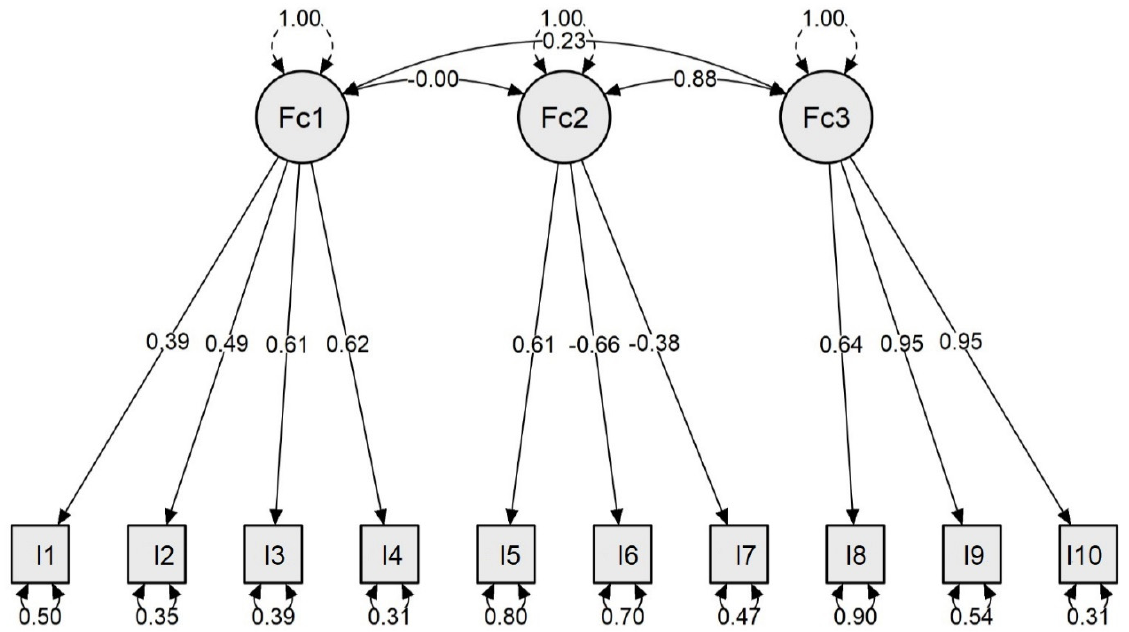
Figure 2. Model of the capacity of students to adapt to digital transformation. Fc1: Factor 1 or motivations; Fc2: Factor 2 or student autonomy; Fc3: Factor 3 or digital pedagogy.